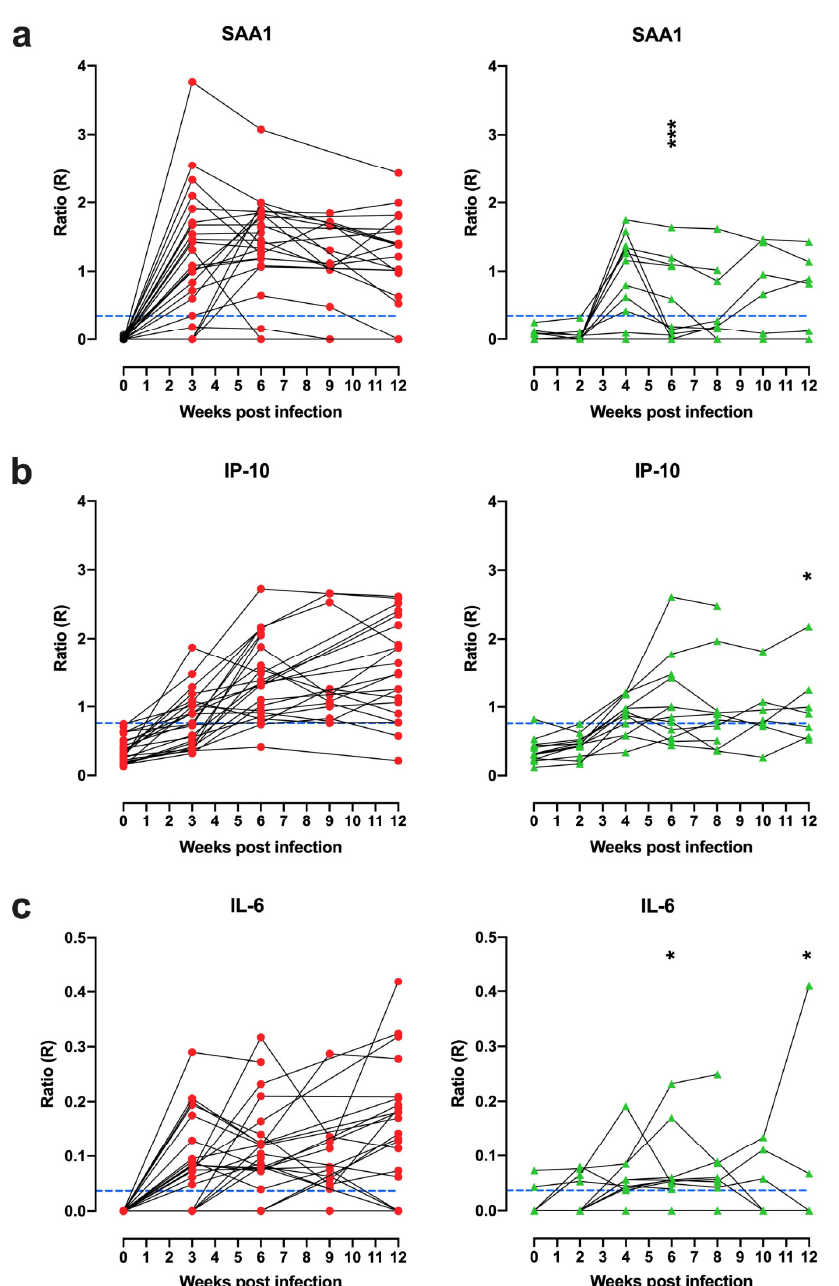
Figure 2. SAA1, IP-10, and IL-6 serum levels increased after MTB infection. SAA1, IP-10 and IL-6 levels were measured by UCP-LFA in serum from high-dose (500 CFU, n = 24, red dots; left panels) or low-dose (15 CFU, n = 12, green triangles; right panels) MTB Erdman infected rhesus macaques ( n = 36) at different timepoints ( x -axis) pre and postinfection. Cutoff values for positivity (blue dashed lines) were calculated by applying the Youden’s index as described in Table 1b. ( a – c ) The levels of SAA1, IP-10, and IL-6 increase after MTB infection. Differences between high and low doses at 3/4, 6, and 12 weeks postinfection were determined by Mann–Whitney U tests indicated in the right panel. p -values: * p < 0.05, *** p <